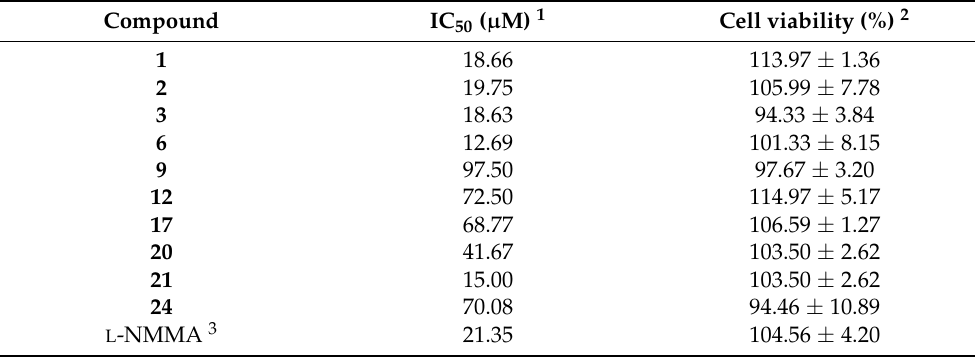
Table 3. Inhibitory effects of selected compounds on nitric oxide (NO) production in lipopolysaccha- ride (LPS)-activated BV-2 cells.